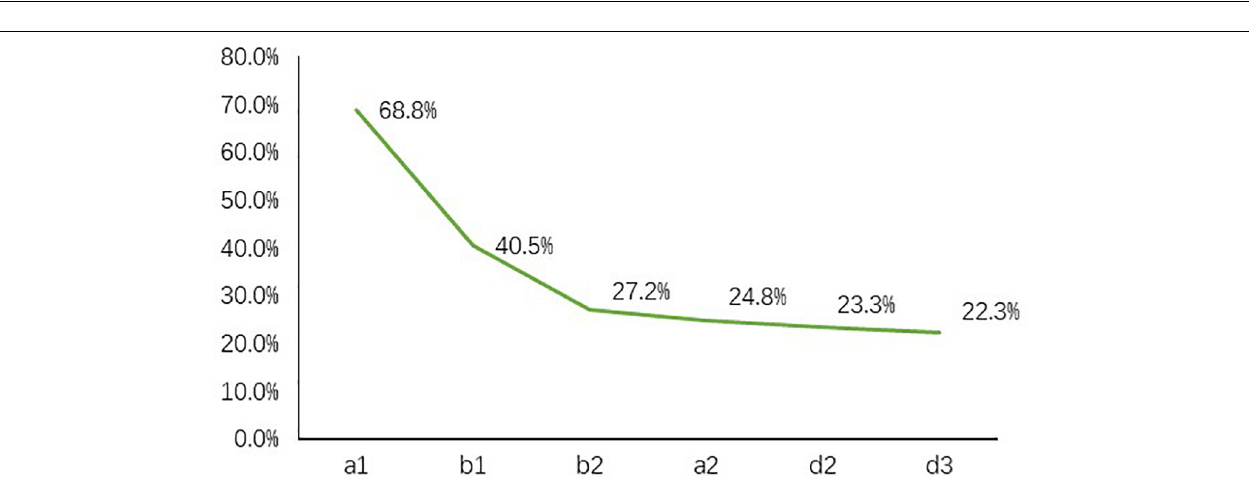
FIGURE 3 | Six steps to quickly identify target users with high global cooperation intention. These six steps represent the six questions in the questionnaire (a1, b1, b2, a2, d2, and d3).